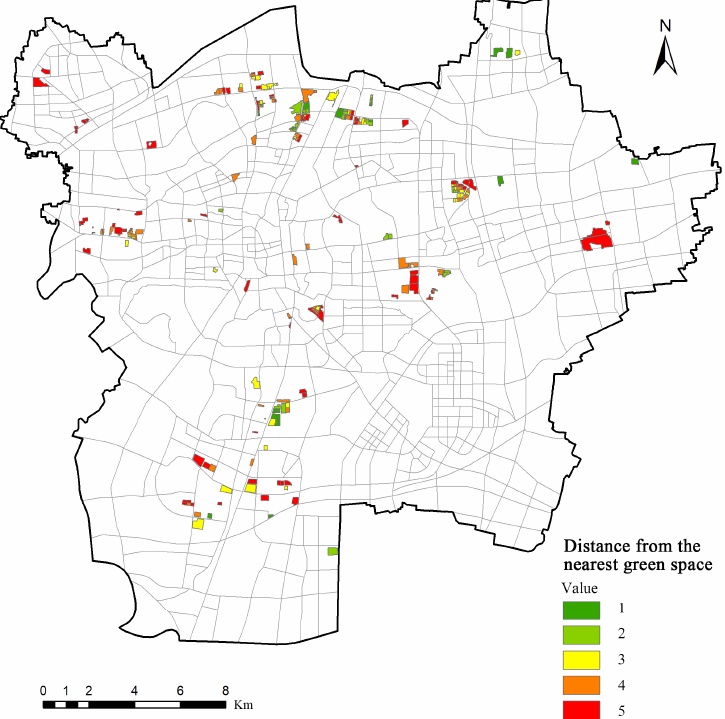
Figure A3. Single value of site suitability based on “Distance from the nearest green space”.